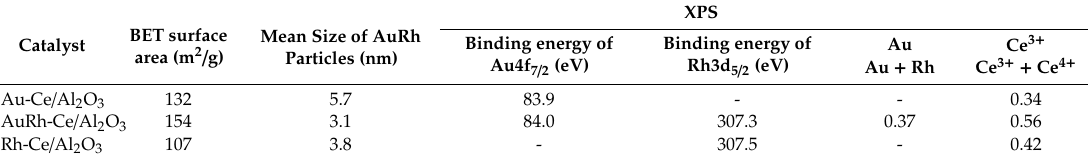
Table 2. BET, STEM, and XPS analyses of Au–CeO x / Al 2 O 3 , AuRh–CeO x / Al 2 O 3 , Rh–CeO x / Al 2 O 3 ,